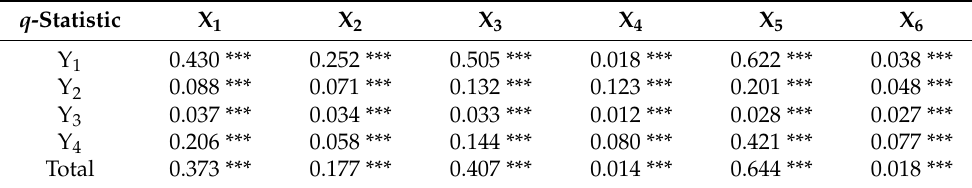
Table 4. Influencing factors and influencing factor detection of suitability level 1 indicators.